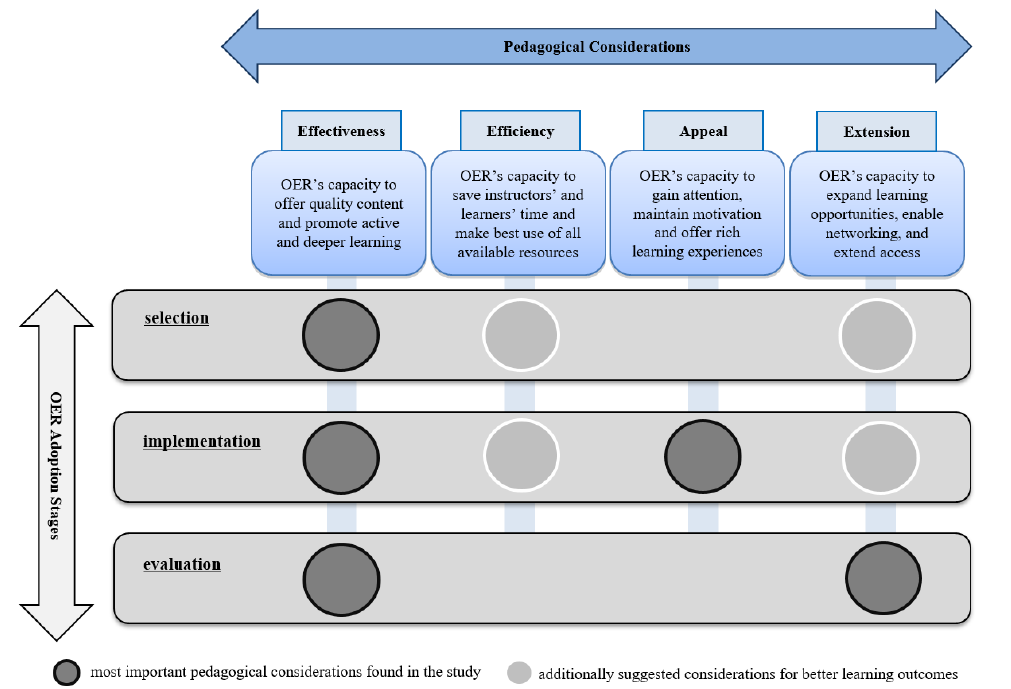
Figure 1. A prospective model of pedagogical considerations at three stages of OER